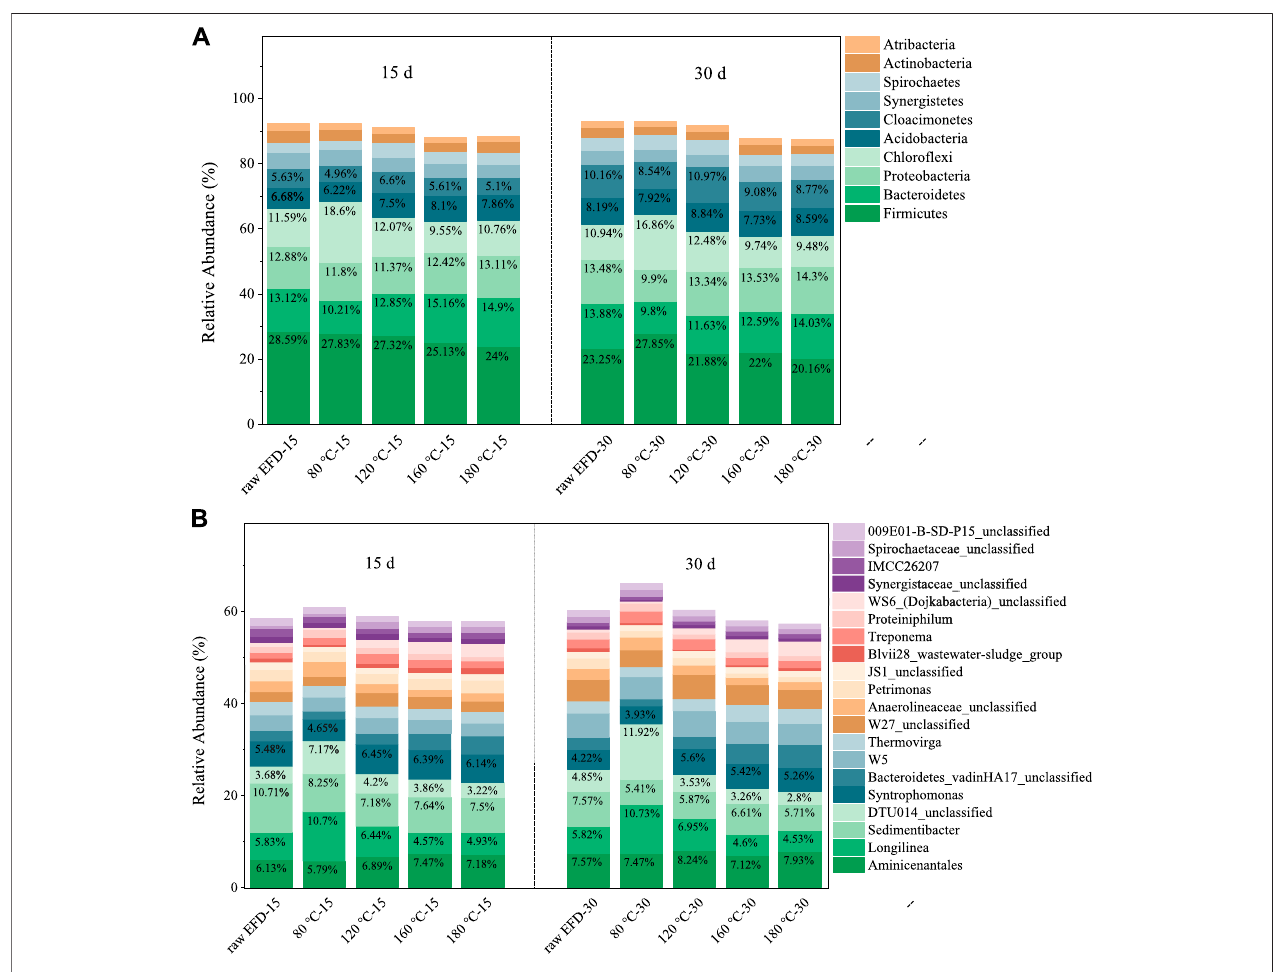
FIGURE 4 | Changes of dominant phylum (A) and genus (B) during AD of the erythromycin fermentation dregs (EFD) with hydrothermal treatment at different temperatures.